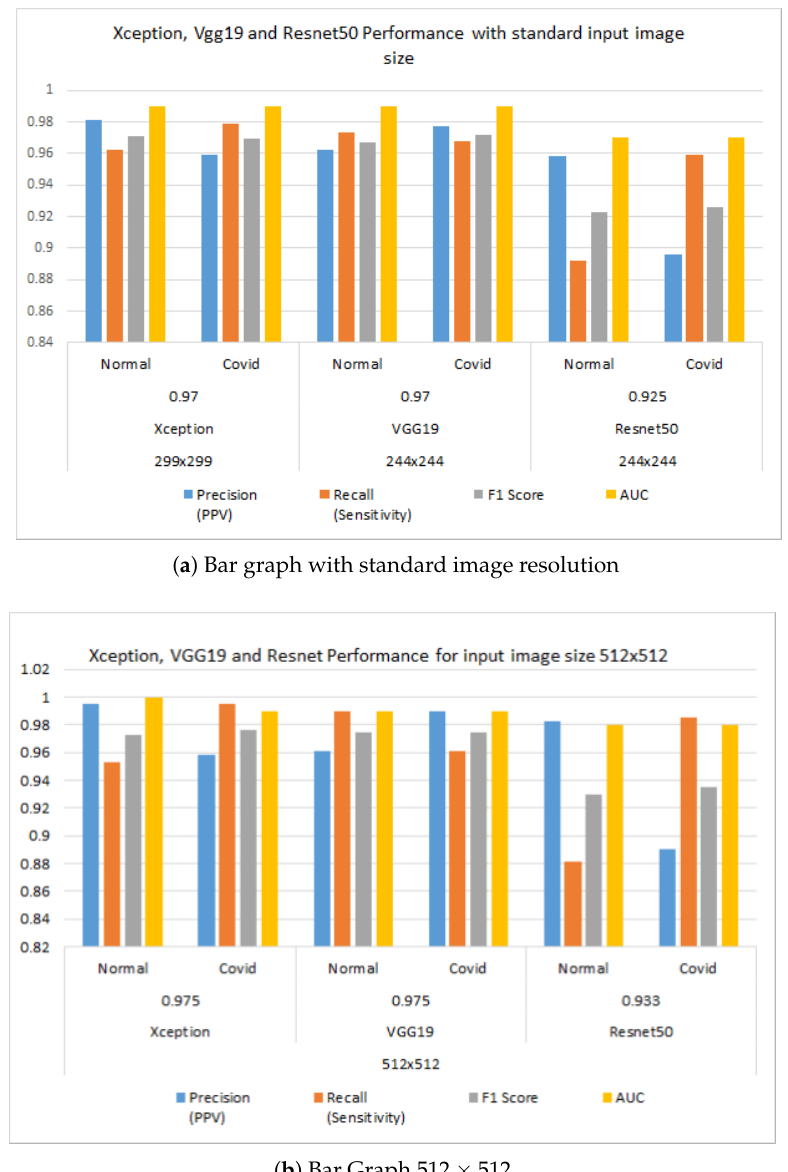
Figure 9. Precision, recall, F1 score and AUC bar bar chart comparison for three models: Xception, VGG19 and Resnet50 while training the model with standard input image size and 512 × 512 input image size. Precision, recall, F1 score and AUC bar bar chart for three models when model is traned with standard image size ( a ). Precision, recall, F1 score and AUC bar bar chart for three models when models are trained with the images size of 512 × 512 ( b ). Resnet performs poorly, and with the increase in image size, accuracy